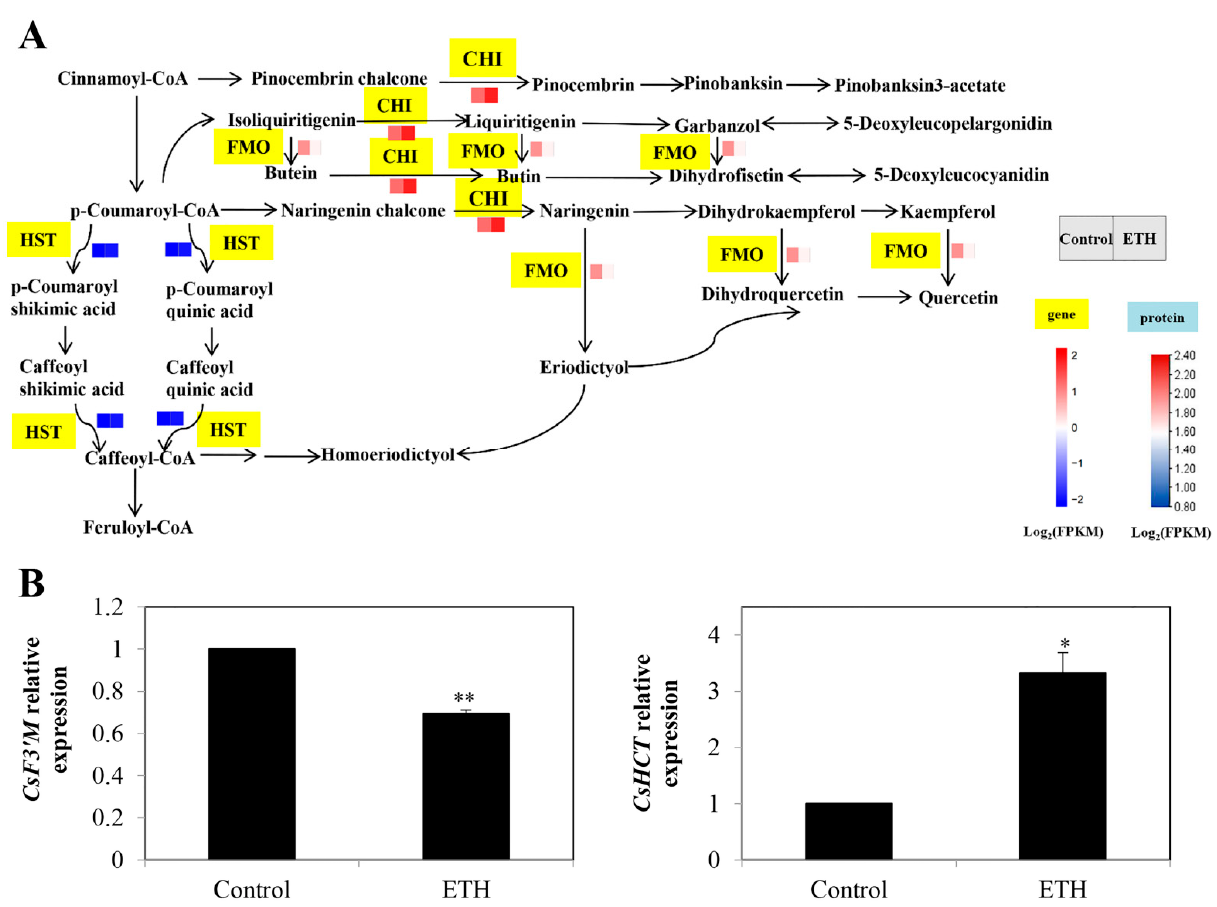
Figure 6. Identification and validation of key DEGs in flavonoid biosynthesis during adventitious root development in cucumber. ( A ) Expression patterns of genes and proteins for flavonoid biosynthesis in secondary metabolism during adventitious root development in cucumber. Annotations of genes and proteins are available in Supplementary Table S9. Black characters with yellow background are genes. The two squares under the names of genes or proteins indicate the change in abundance of the control and ETH. A red square means up-regulation, whereas a blue square means down-regulation. ( B ) The expression profiles of 2 genes related to flavonoid biosynthesis during adventitious root development in cucumber. Asterisk (*) and double asterisk (**) indicate the significance at p < 0.05 and p < 0.01, respectively. The bar represents the value of standard error. Values represent the mean ± SE of three replicates. Each experiment was repeated three times